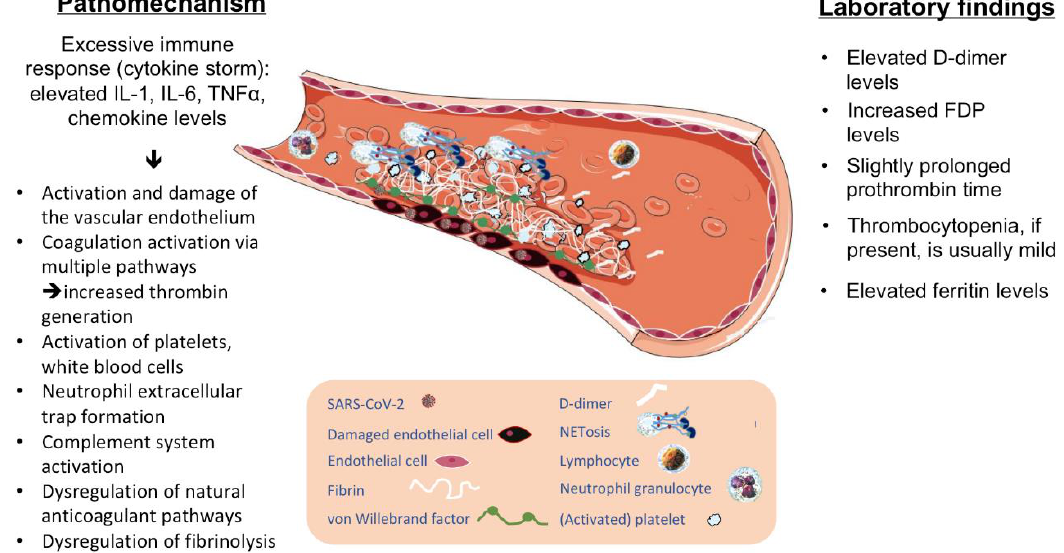
Figure 1. Pathophysiology and laboratory findings in COVID-19-associated coagulopathy. FDP, fibrin degradation products; IL, interleukin; NET, neutrophil extracellular traps; TNF, tumor necrosis factor.